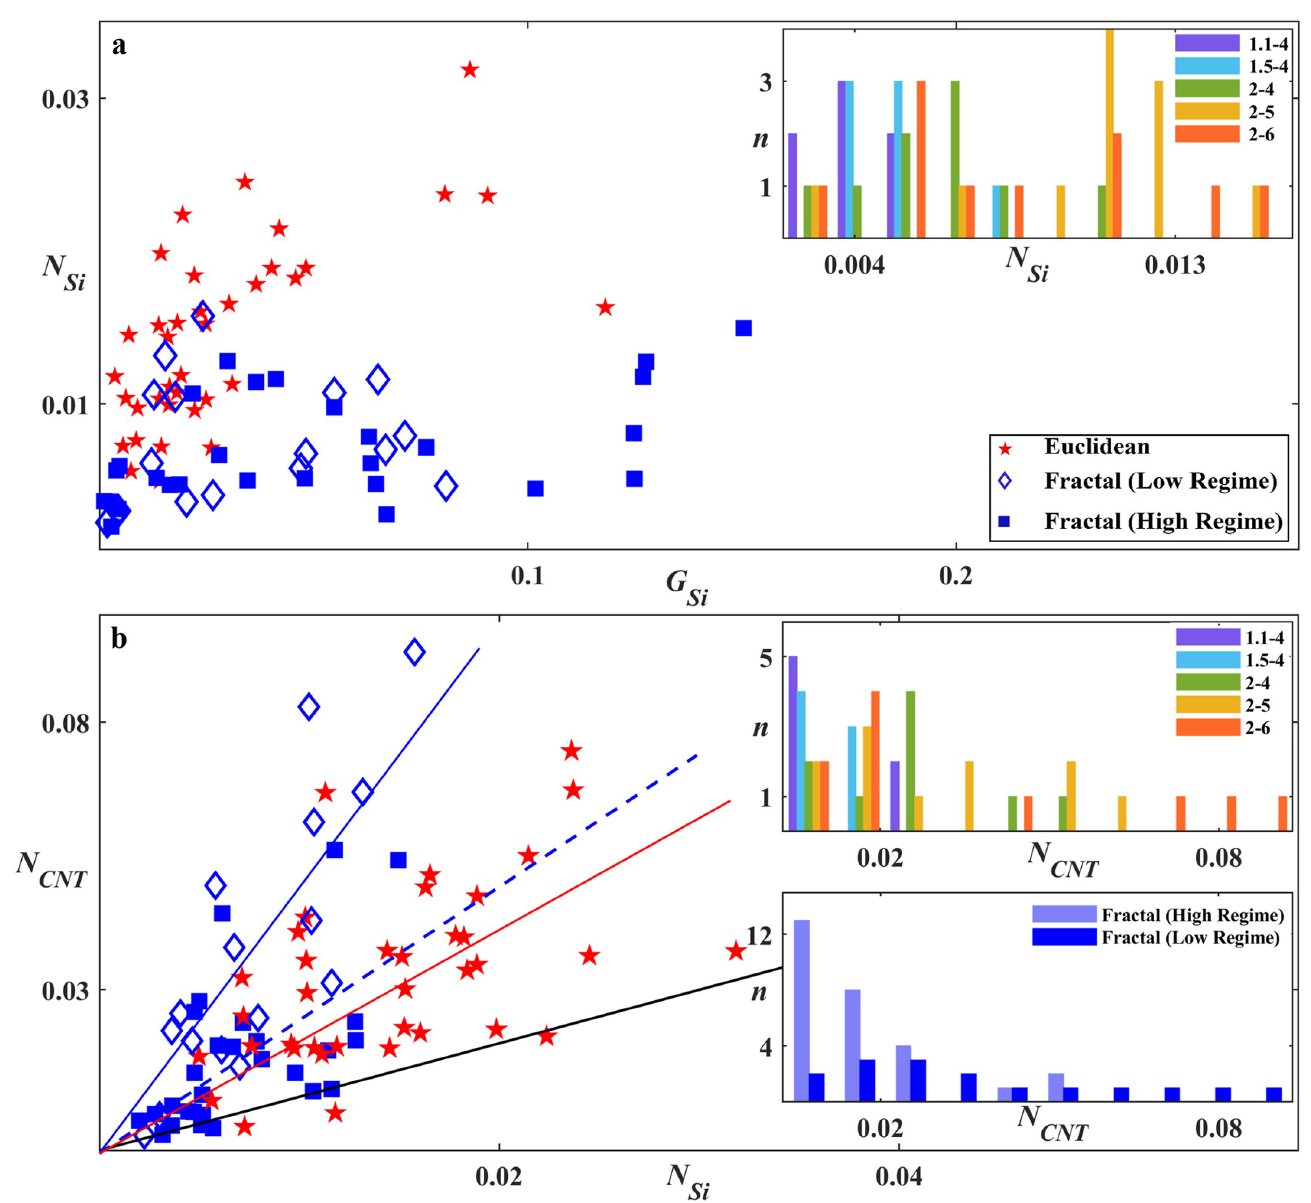
Fig 9. Study of the relationship between G Si , N Si , and N CNT for fractal and Euclidean electrodes. (a) Scatterplot of N Si versus G Si for 17 DIV Euclidean (red pentagram), low (diamond) and high (filled square) regime fractals. Inset of (a) Histogram of the number of electrodes n with a given N value for all fractals, Si grouped according to D and m . (b) Scatterplot of N CNT vs N Si for 17 DIV Euclidean, low, and high regime fractals. The solid black line represents the N CNT = N Si condition. The solid blue, dashed blue, and solid red lines are fits through zero for the low regime fractal, high regime fractal, and Euclidean electrodes, respectively. Top inset of (b) Histogram of the number of electrodes n with a given N CNT for all fractals, grouped according to D and m . Bottom inset of (b) Histogram of the number of electrodes n with a given N for low and high regime CNT